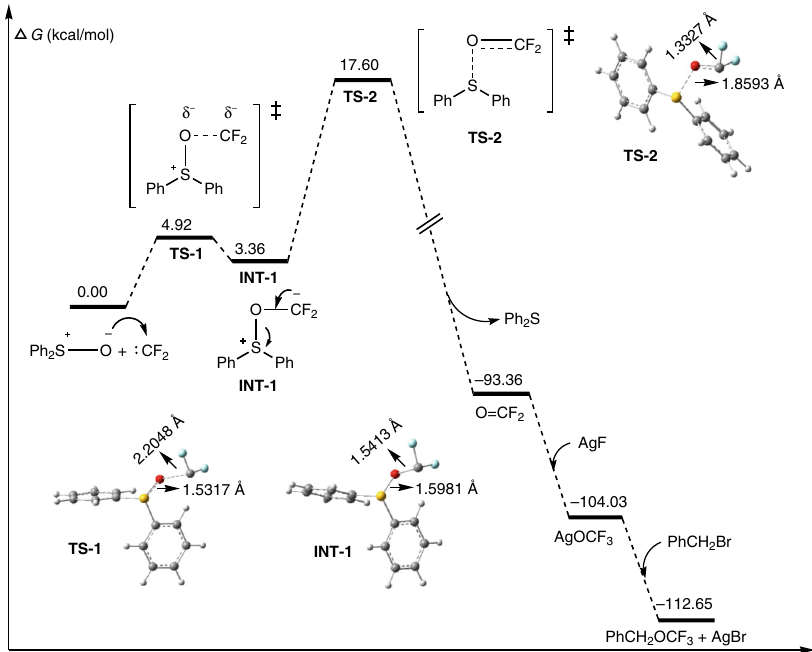
Fig. 3 Relative free energies for di fl uorocarbene-oxidation-based tri fl uoromethoxylation. All calculations were performed in Gaussian 09 D01 radical 38 – 40 , and transition-metal-promoted 41 – 44 reactions. As the use of a CF 3 O-containing reagent is required, these approaches cannot be directly applied to 18 O-labeling tri fl uoromethoxylation.